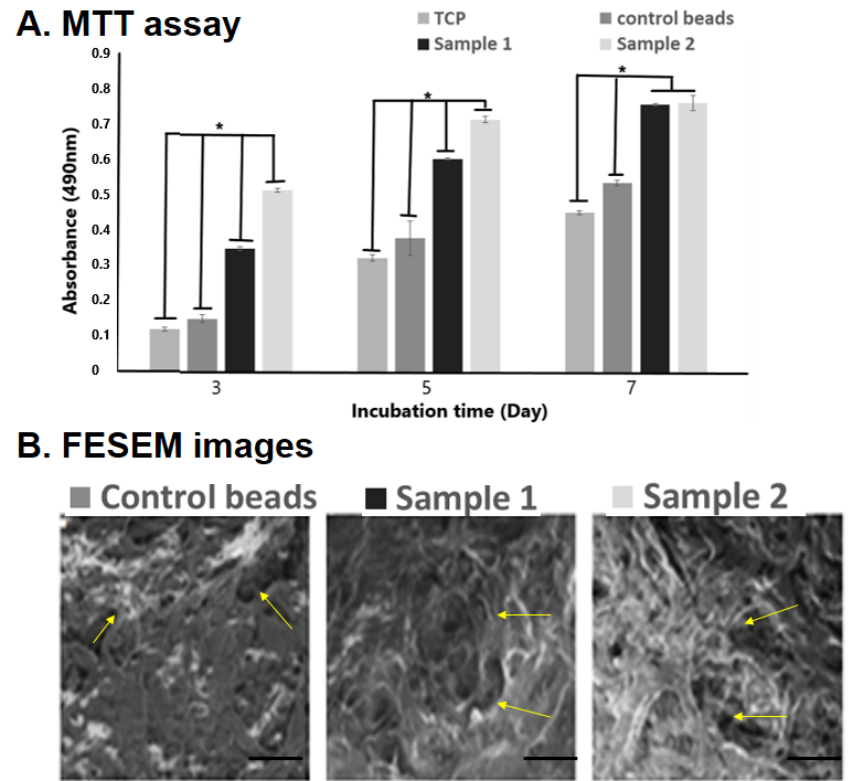
Figure 4. Fabricated polymeric beads’ biocompatibility study: MTT assay to check cell viability ( A ), and cell-seeded matrix FESEM images at 10 kX magnification (100 µ m scale) ( B ) to show cell prolif- eration and adherence over the matrix (yellow arrows). Here * indicated the significant difference between the samples at p ≥